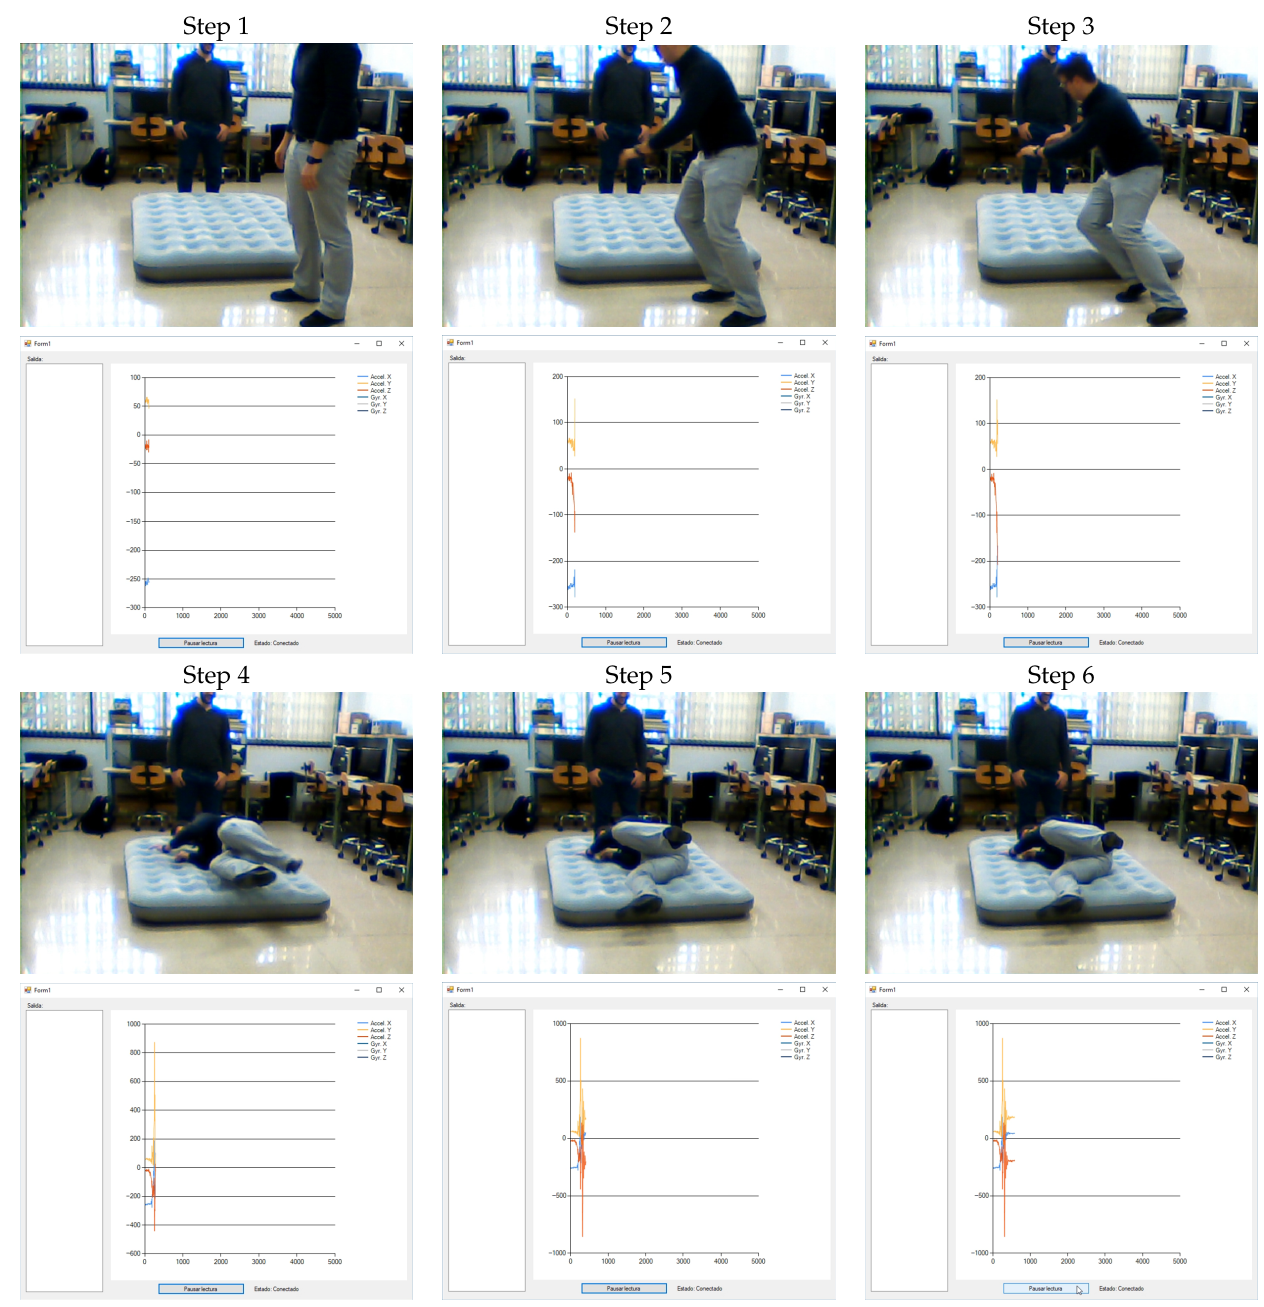
Figure 2. Monitoring application and videoclip during a Fall event recording sequence (in order, from step 1 to